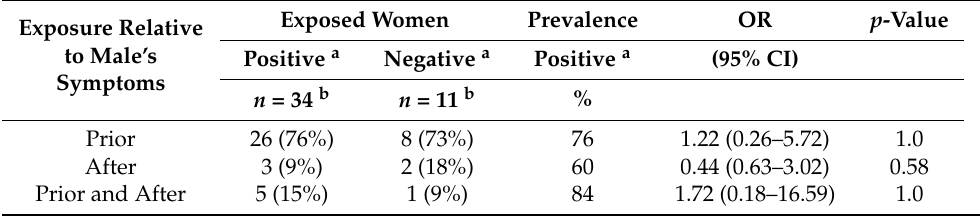
Table 2. Chronology of exposure to men with gonococcal urethritis relative to onset of symptoms. Exposure Relative